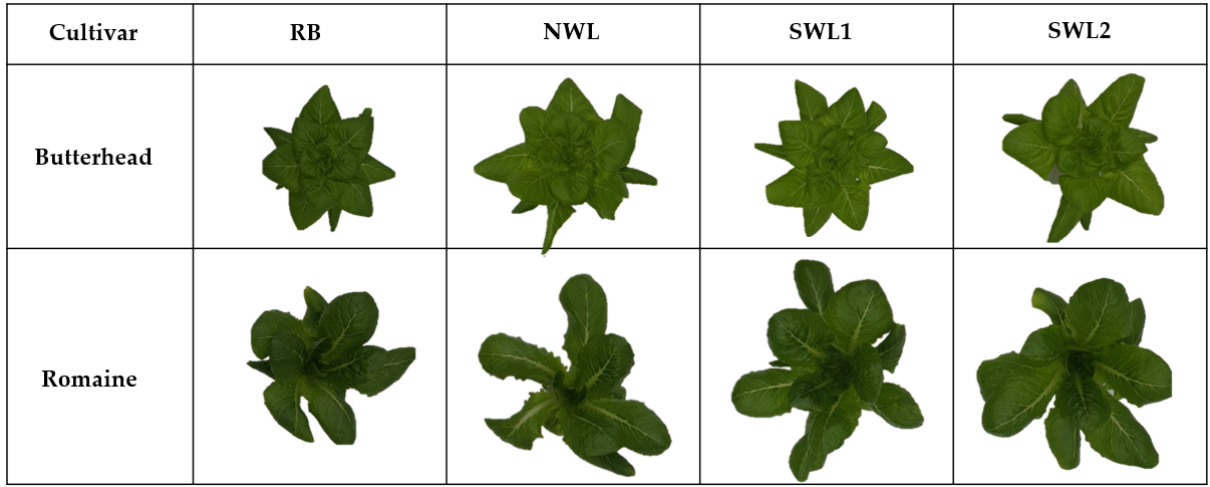
Figure 6. Butterhead lettuce and romaine lettuce grown under various light sources with the same PPFD after 4 weeks of transplanting.